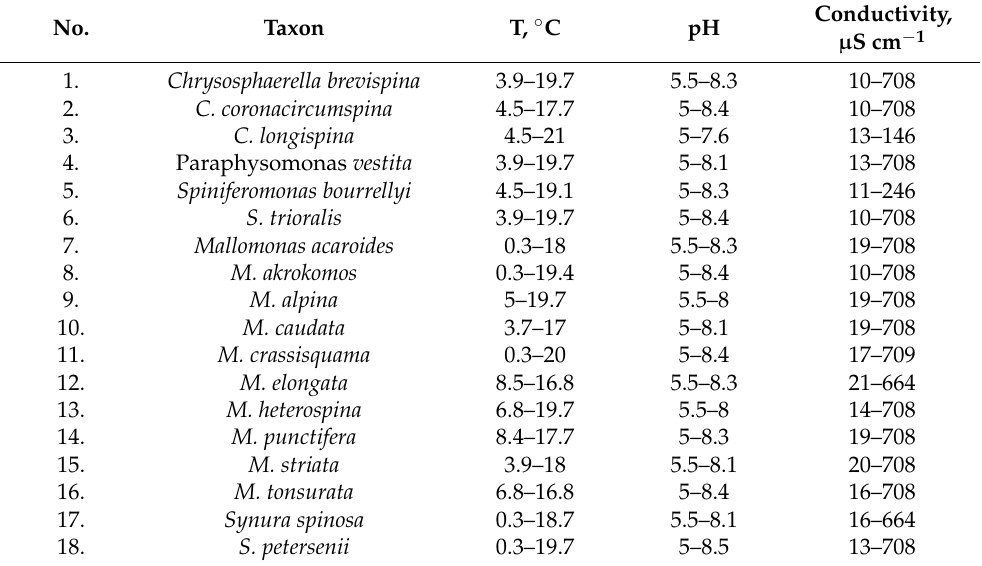
Table 3. Species of silica-scaled chrysophyceans found in the majority of the water bodies located above the 60th parallel north (see Table 1 for